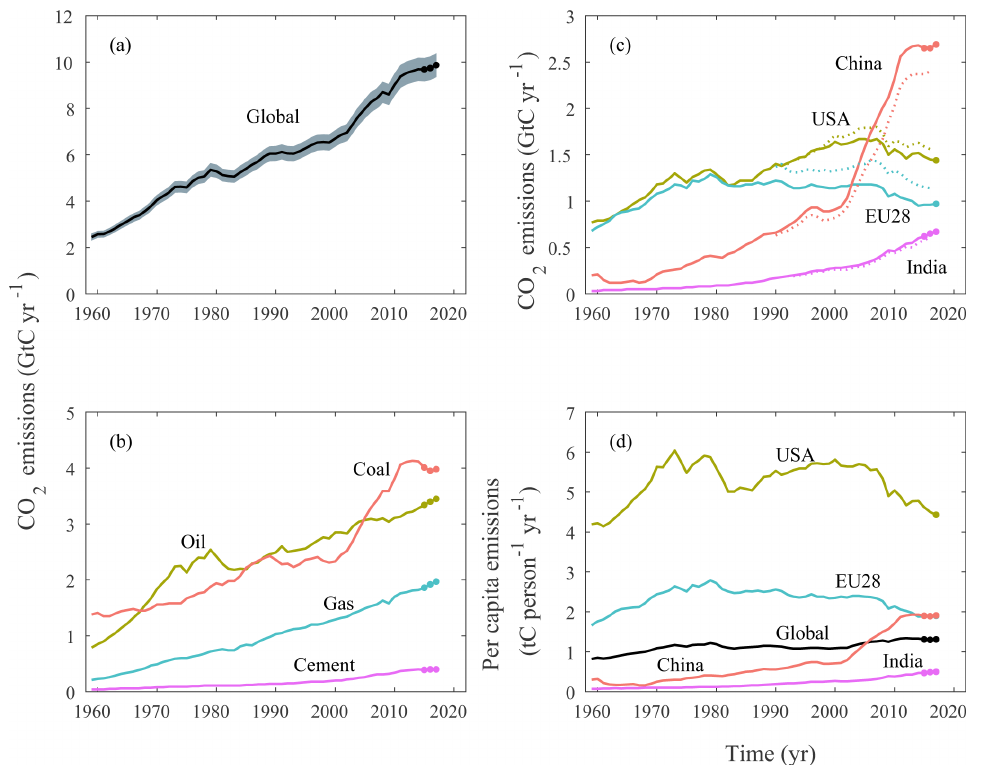
Figure 5. Fossil CO 2 emissions for (a) the globe, including an uncertainty of ± 5% (grey shading), and the emissions extrapolated using BP energy statistics (black dots); (b) global emissions by fuel type, including coal (salmon), oil (olive), gas (turquoise), and cement (purple), and excluding gas flaring, which is small (0.6% in 2013); (c) territorial (solid lines) and consumption (dashed lines) emissions for the top three country emitters (US – olive; China – salmon; India – purple) and for the European Union (EU; turquoise for the 28 member states of the EU as of 2012); and (d) per capita emissions for the top three country emitters, the EU (all colours as in panel c ), and the world (black). In (b–c) , the dots show the data that were extrapolated from BP energy statistics for 2014–2016. All time series are in GtCyr − 1 except the per capita emissions (d) , which are in tonnes of carbon per person per year (tCperson − 1 yr − 1 ). Territorial emissions are primarily from Boden et al. (2017) except national data for the US and EU28 (the 28 member states of the EU) for 1990–2016, which are reported by the countries to the UNFCCC as detailed in the text; consumption-based emissions are updated from Peters et al. (2011a). See Sect. 2.1.1 for details of the calculations and data